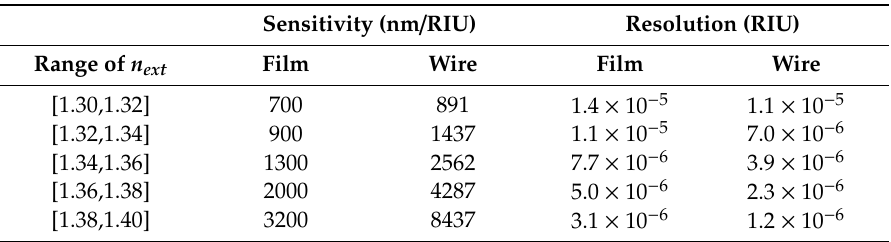
Table 2. Comparison of the sensitivity and resolution for the two structures, one with metallic film and the other one with the metallic